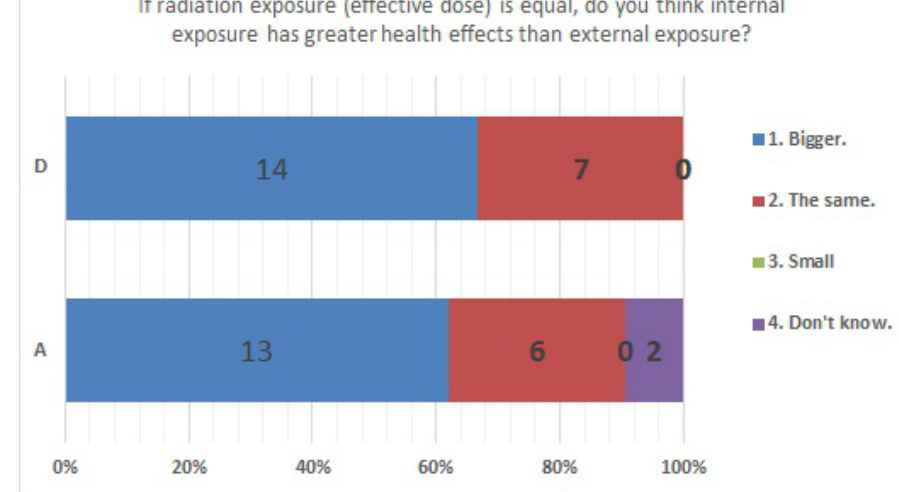
Figure 8. Responses to item No. 25.